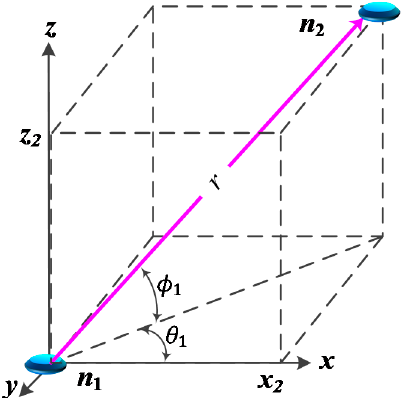
Figure 7. Representation of the spherical coordinate system where the angle 𝜃 lies in 𝑥𝑦 plane, the angle 𝜙 lies in the 𝑦𝑧 plane and the length of the vector connecting the nodes is denoted by 𝑟 .